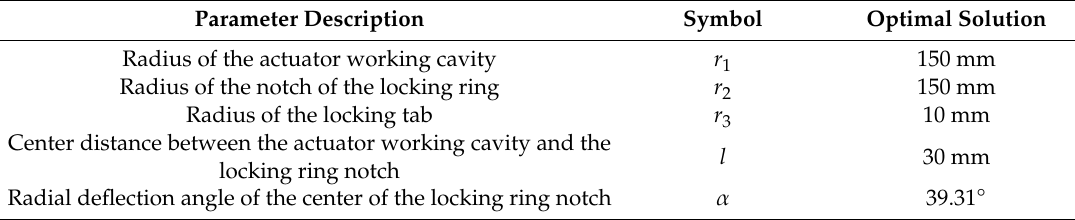
Table 6. The improved parameter set of the low-power holding